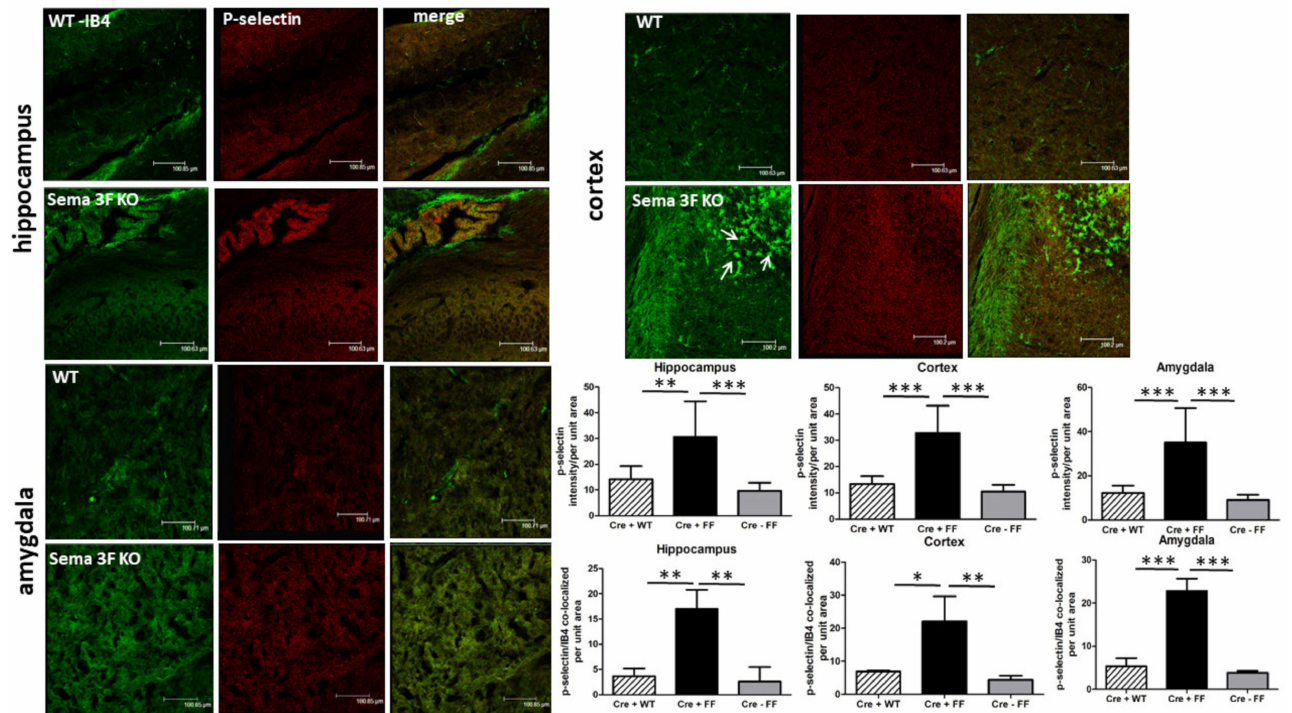
Figure 9. Co-Localization of Activated Microglia and Platelets in Sema 3F KO Mice . Represen- tative immunofluorescent staining of p-selectin (red) and isolectin B4 (green) in hippocampus ( upper left ), cortex ( upper right ), and amygdala ( lower left ) tissue from Sema 3F KO mice and their littermate wild type (WT) mice. White arrows show IB4-positive activated cortical microglia. Quantifications of p-selectin (upper part of the lower right panel) showed a significant increase in p-selectin immunoreactivity of Sema 3F KO mice *** p ≤ 0.0001; ** p ≤ 0.001; n = 3–5 and increased p-selectin-IB4 co-localization (bottom part of the lower right panel) in all three brain areas of Sema 3F KO mice compared to the two control mice groups. *** p ≤ 0.0001; ** p ≤ 0.001; * p ≤ 0.01; n =